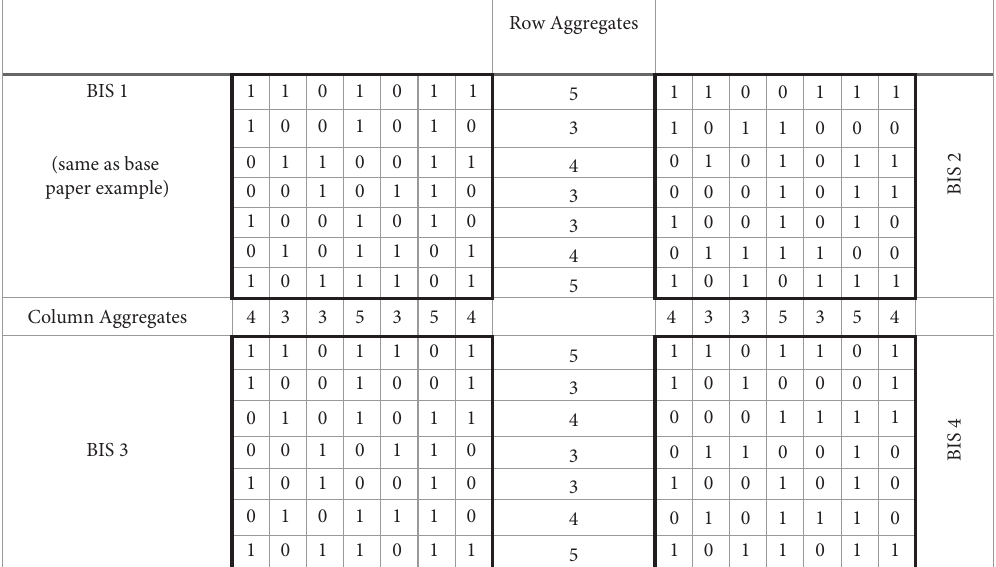
Figure 1: Four BISs having the same aggregates due to circular patterns; only row and column aggregates are shown here. Readers can check that diagonal aggregates are also the same for these